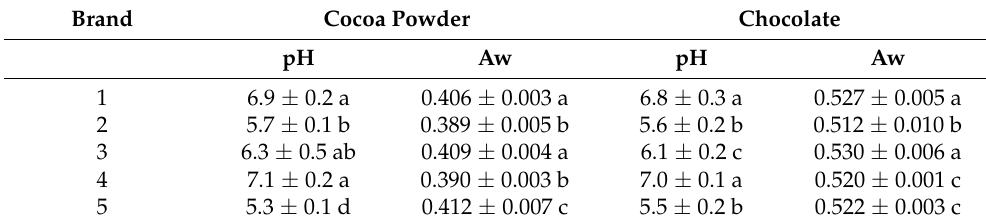
Table 5. Chemical and physical characteristics of cocoa powder and chocolate bars. Brand Cocoa Powder